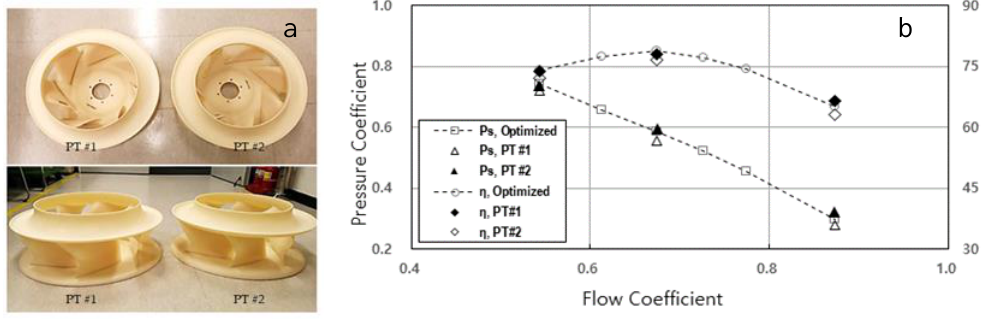
Figure 12. Prototype test results: ( a ) Prototype fan image; ( b ) Comparison of performance between simulation and experimental results of the prototype fan (at 1100 rpm).